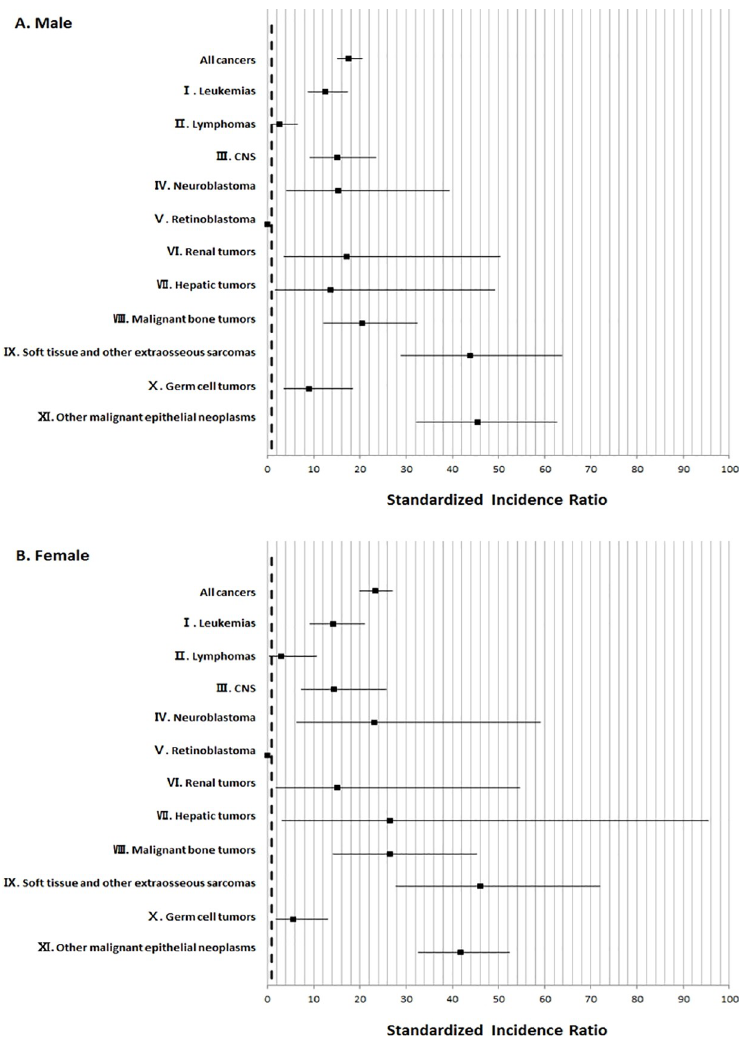
Fig 1. SIRs by sex of SMNs among childhood survivors of initial cancer during 1993–2012. SIR: standardized incidence ratio, EAR: excess absolute risk.